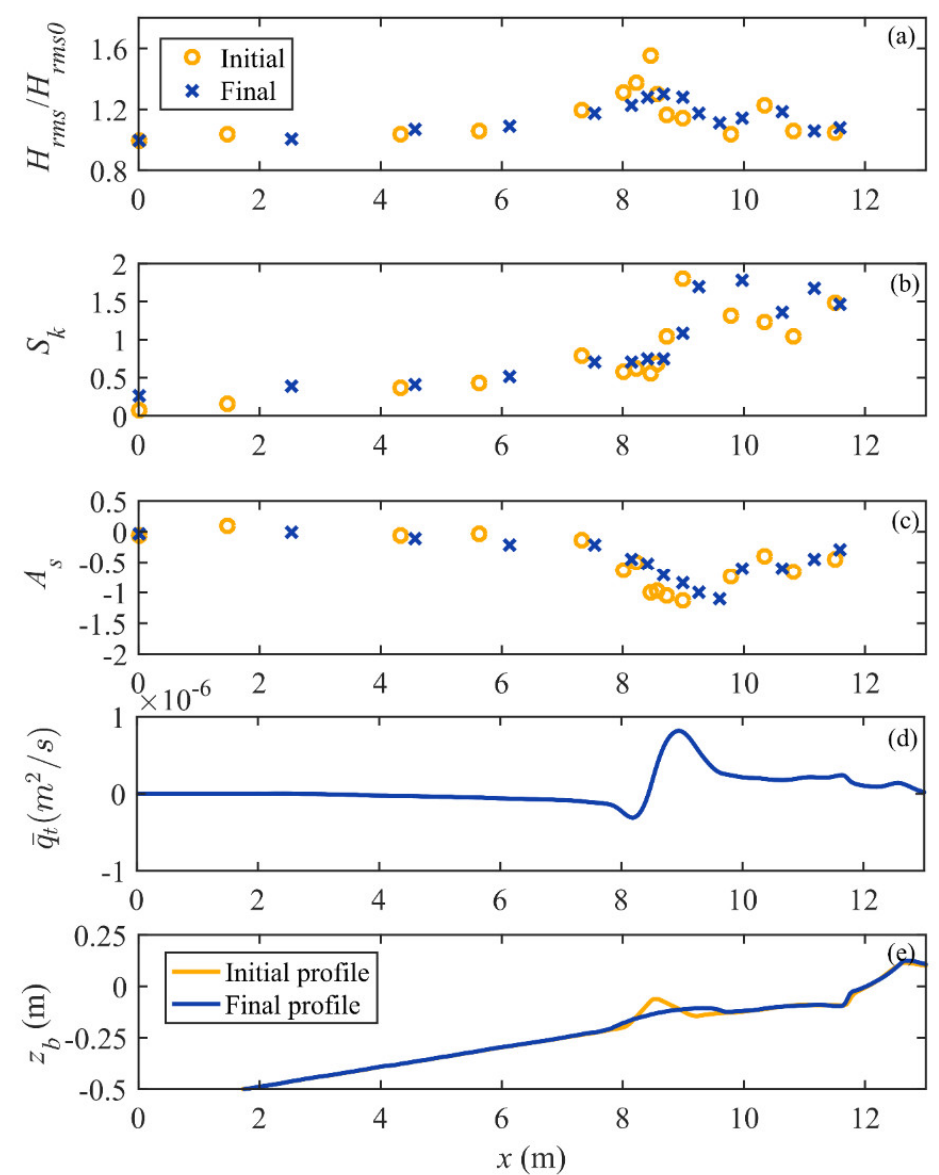
Figure 5. Measured ( a ) normalized root-mean-square wave height, ( b ) wave skewness, ( c ) wave asymmetry, ( d ) time-averaged sediment transport rate across the ( e ) initial and final profiles for case A1_2. Subscript ‘0′ means the quantity at x = 0 m. As can be seen in Figure 6a, the root–mean–square wave height distribution across the profile in case E1_1 shows a similar pattern that wave height increases on the nourishment and decreases shoreward. On the initial profile in Figure 6b,c, the trends of magnitudes of S k and A s are similar to those in case A1_2. As the shoreface nourishment moves onshore, the positions of maximum S k and A s move shoreward. For case E1_1, three positive peaks occur on the profile, representing the onshore migration of the shoreface nourishment and the inner bar, and the formation of the